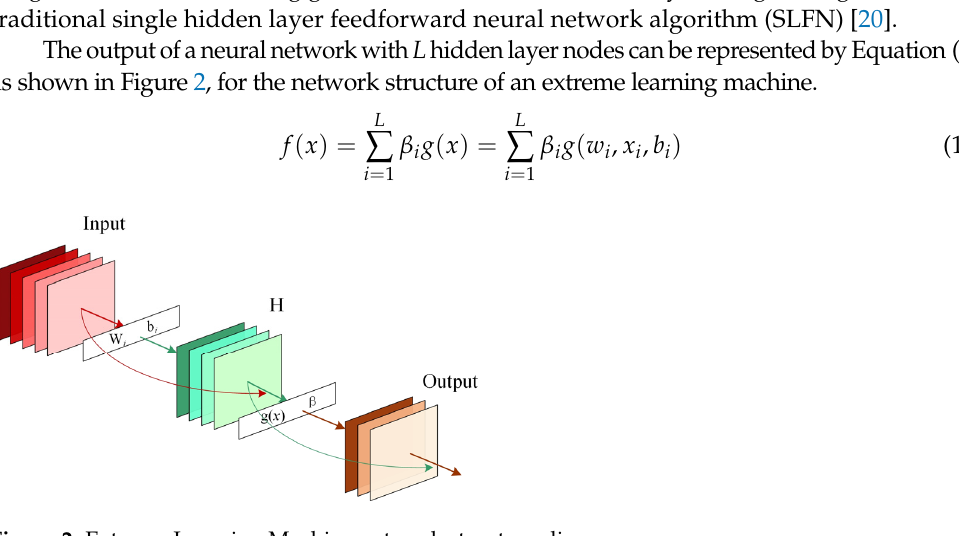
Figure 2. Extreme Learning Machine network structure diagram.